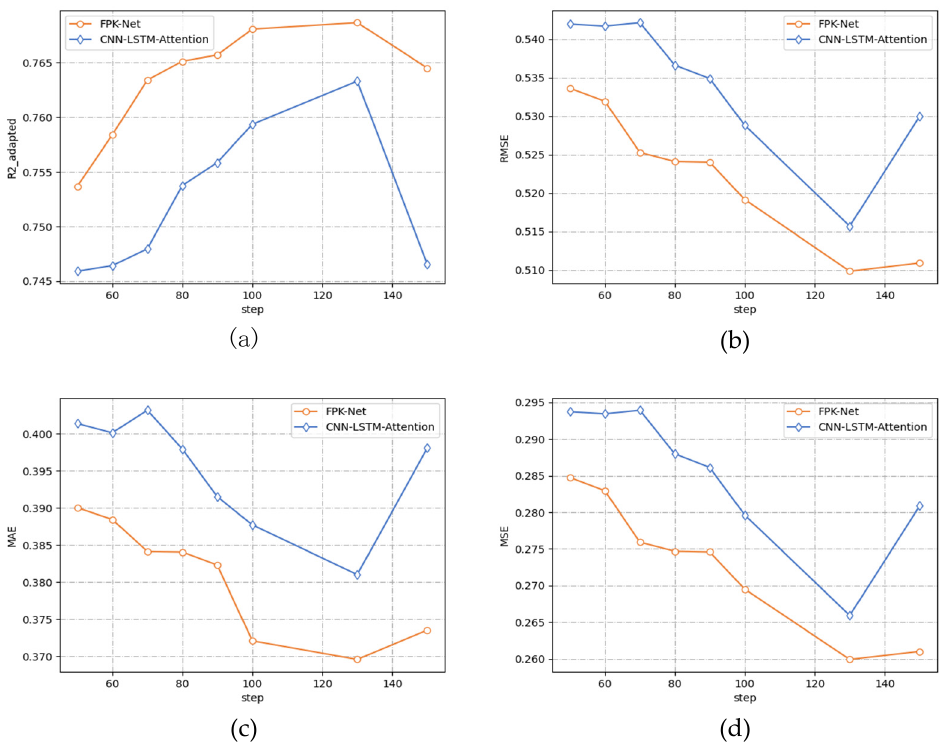
Figure 8. Performance comparison using different values for the sliding window. ( a ) Performance ( R 2 ) comparison using different values for the sliding window. ( b ) Performance ( RMSE ) comparison using different values for the sliding window. ( c ) Performance ( MAE ) comparison using different values for the sliding window. ( d ) Performance ( MSE ) comparison using different values for the sliding window.